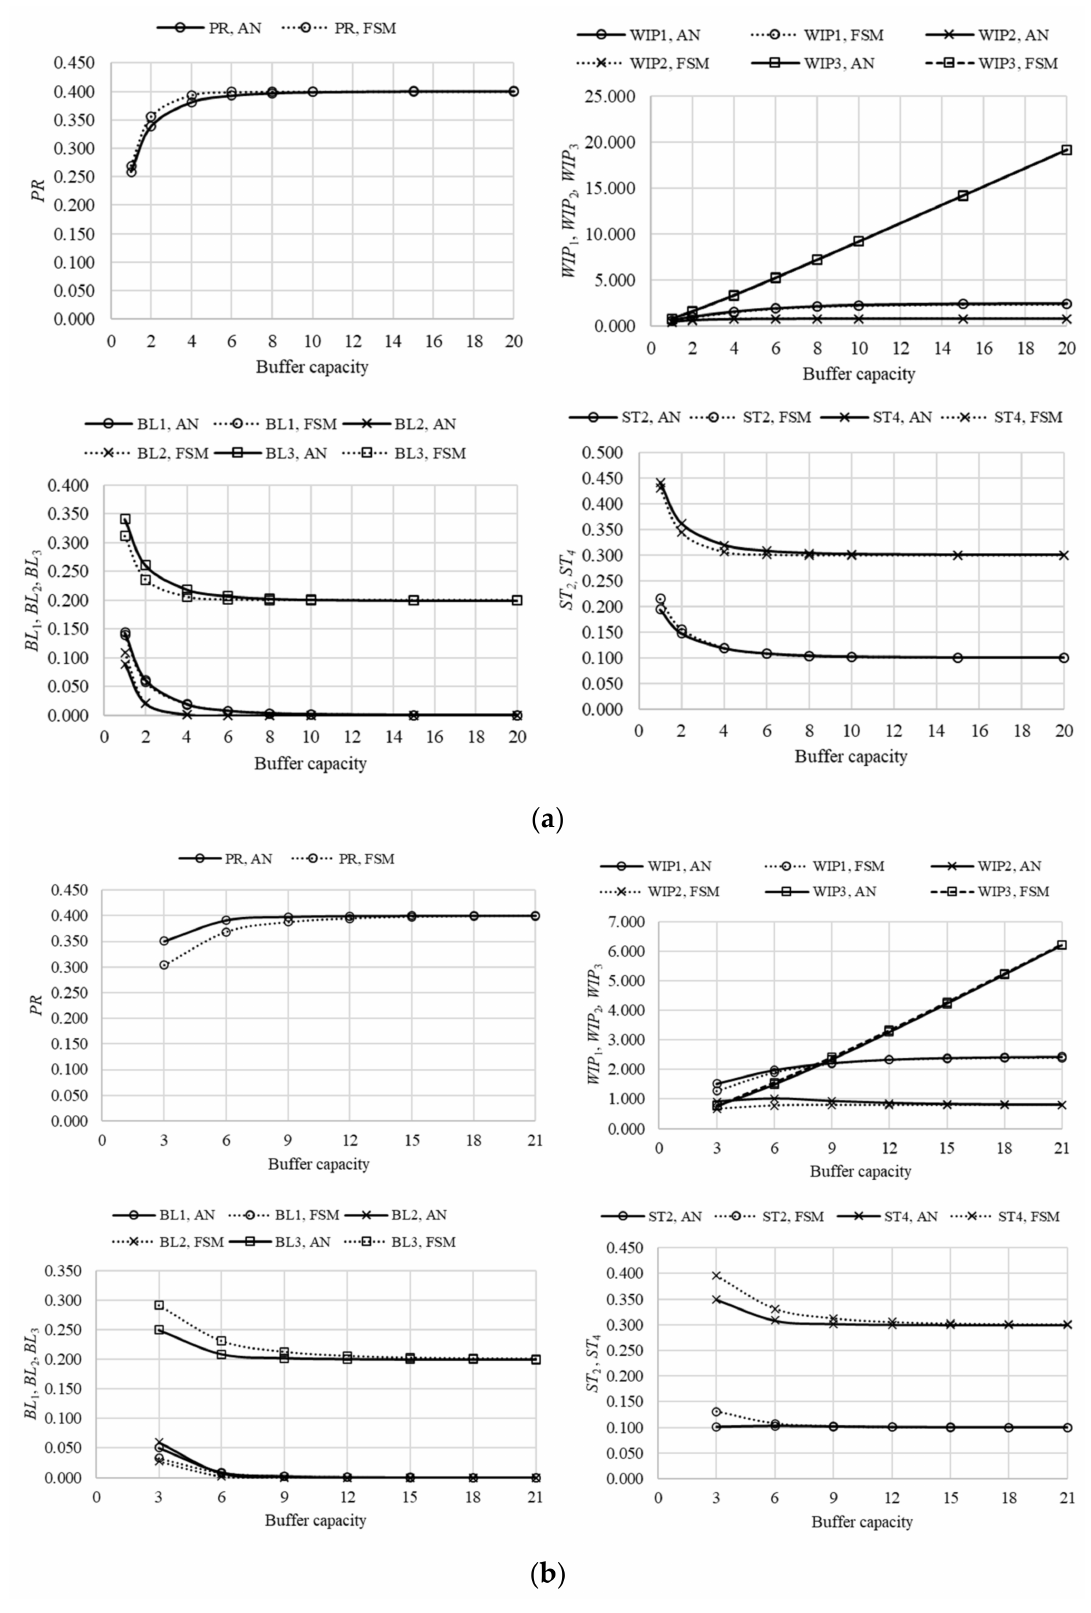
Figure 6. Comparison of the performance measures in the case of line L4: ( a ) N 1 = N 2 = N 3 = N ; ( b ) N 1 = N , N 2 = 2 / 3 N , N 3 = 1 / 3 N